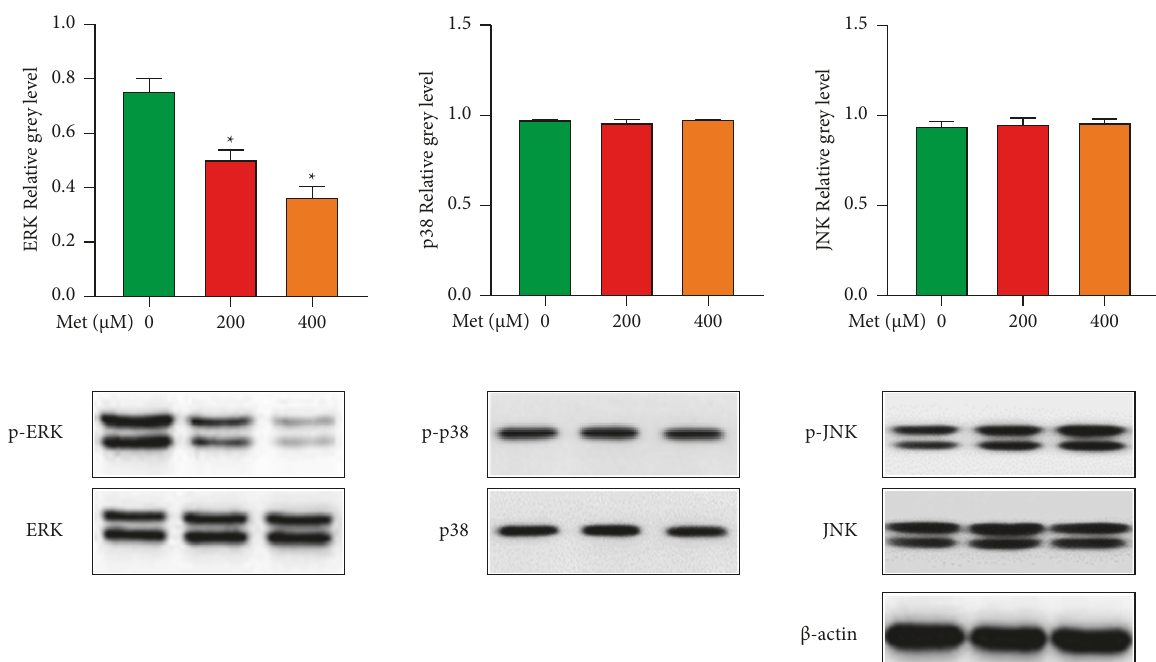
Figure 5: Met suppressed osteoclastogenesis by blocking the ERK signaling pathway while having a limited effect on the p38 or JNK signaling pathways. BMMs were induced and cultivated in media containing 50 ng/mL M-CSF, 100ng/mL RANKL, and 0, 200, or 400 ng/ mL Met for 5d before being collected and lysed for Western blot